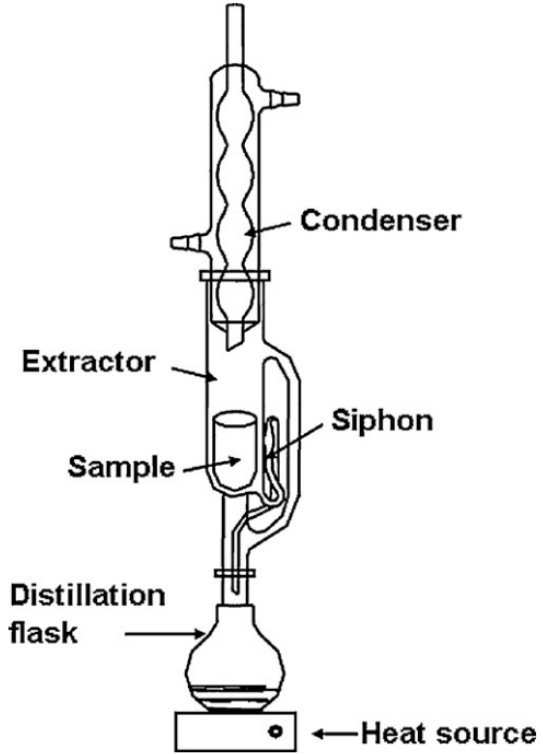
Figure 16. Experimental setup for experimental Soxhlet extraction. Adapted from [177].